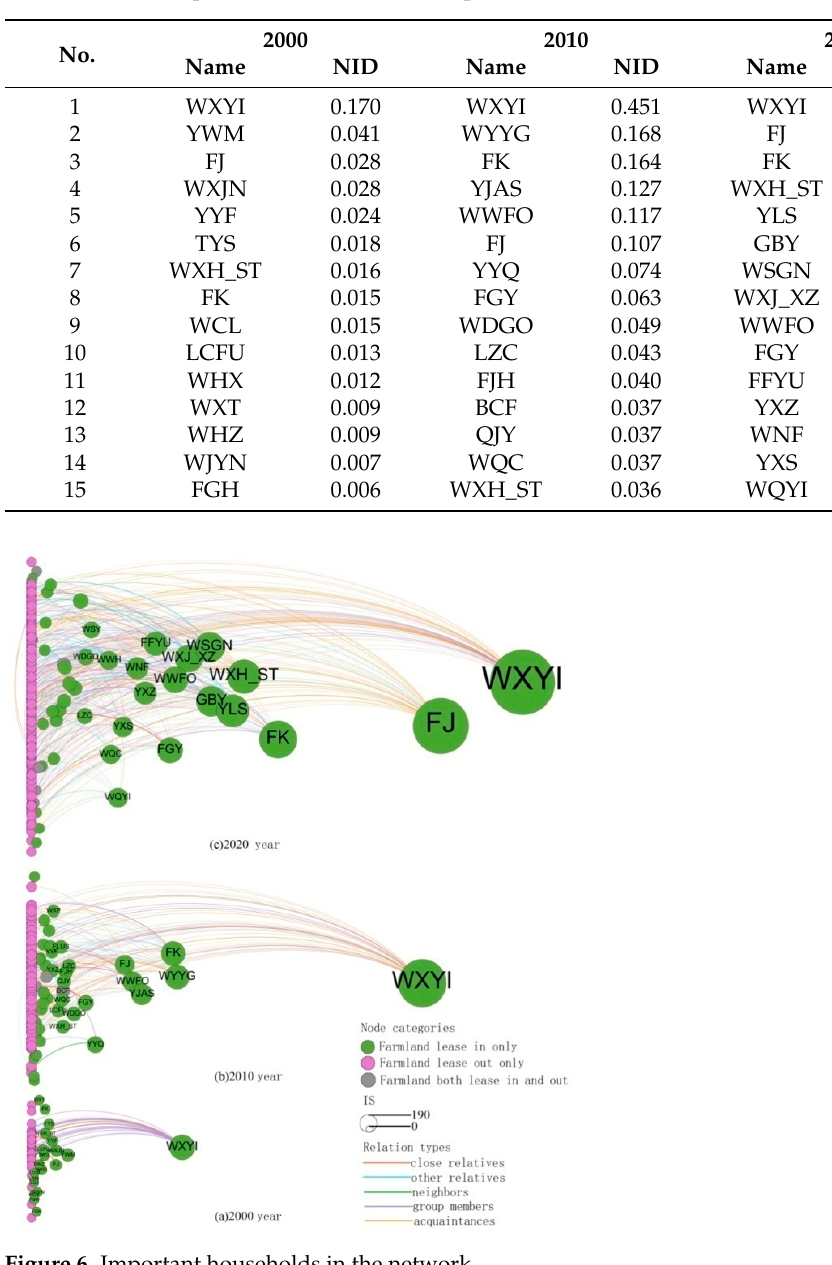
Figure 6. Important households in the network.